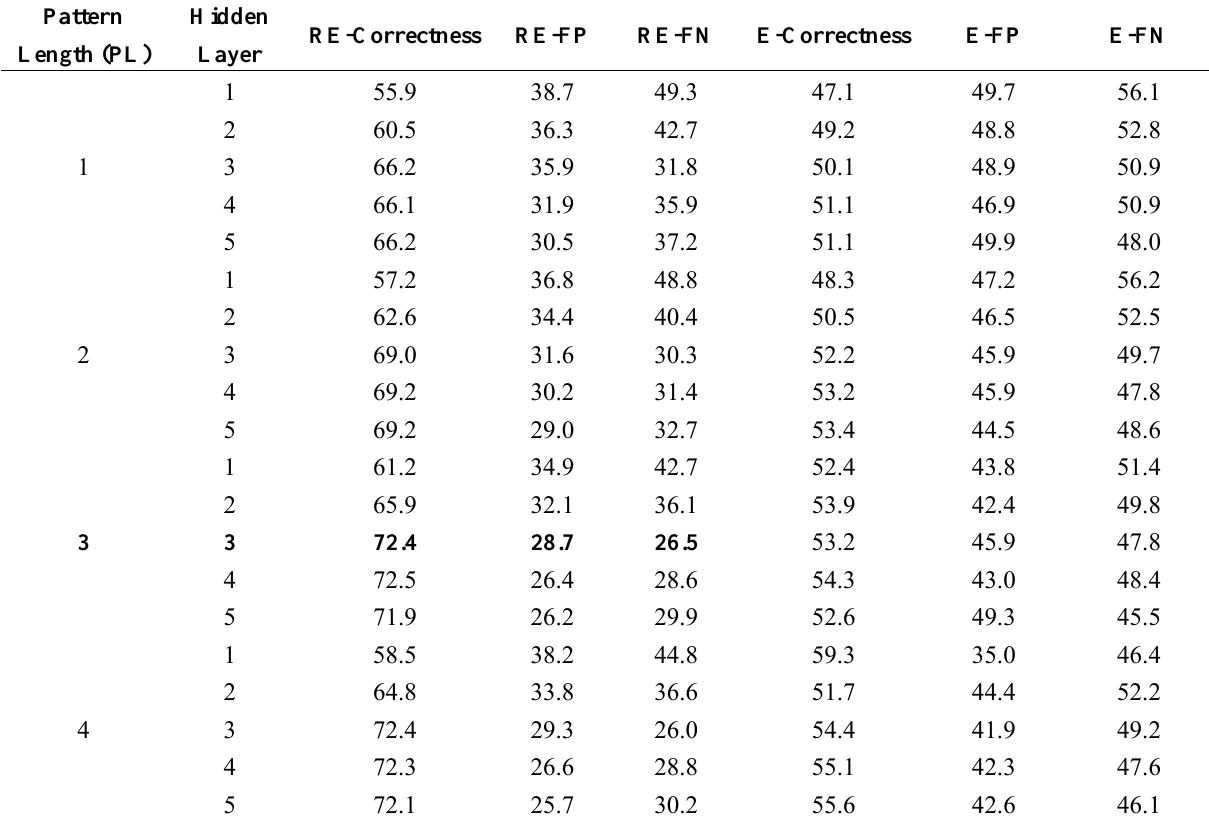
Table 2. Experimental results of ANN classifier